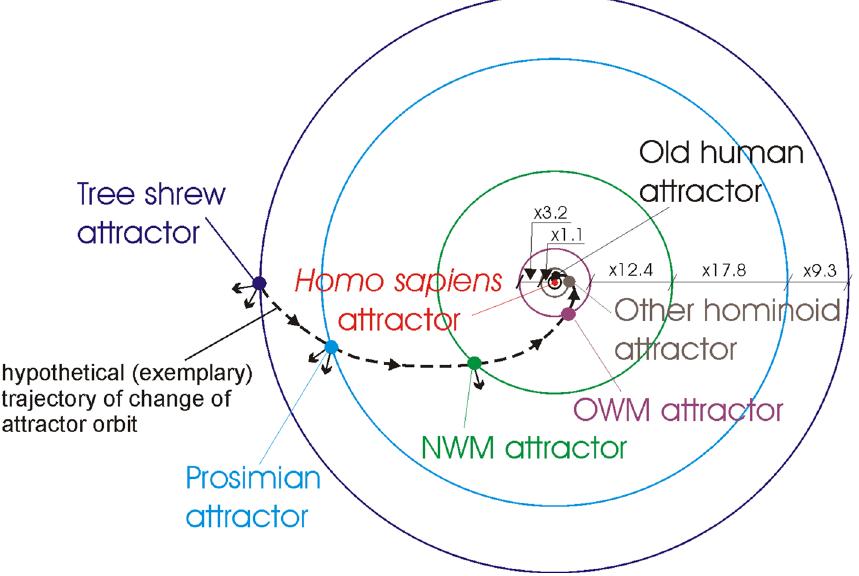
Figure 1. Orbits and genome attractors during human evolution. Tree shrew attractor orbit is disturbed most strongly by the attraction in the Asian rat {#26} (with average similarity to all organisms in the attractor equals to 0.0025) and Domestic sheep {#35} (0.0014) directions—schematically presented by small arrows from the attractor. Prosimian attractor orbit is disturbed most strongly by the attraction in the Horse {#32} (0.0037) and Chinese hare {#24} (0.0013) directions. NWM attractor orbit is disturbed most strongly by the attraction in the Domestic sheep {#35} (0.0015)